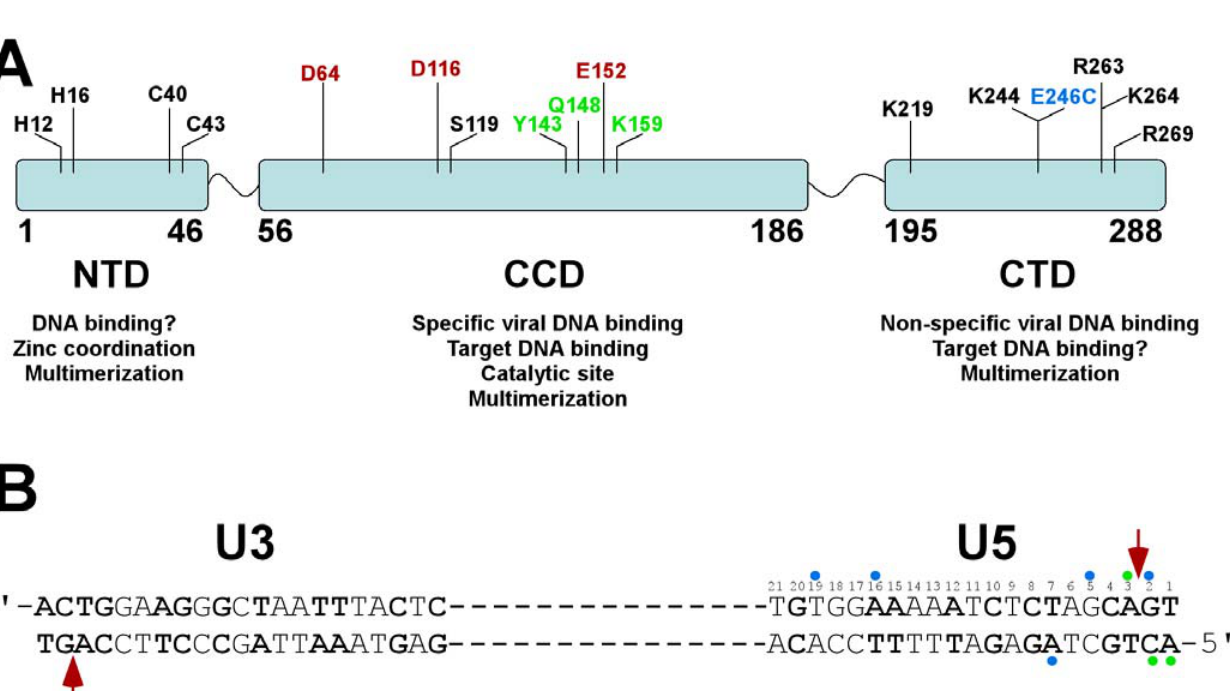
Figure 2. (A) Schematic presentation of the three domain structure of HIV-1 IN. The NTD residues (H12, H14, C40 and C43) coordinate Zn and contribute to the functional multimerization. It is not entirely clear whether the NTD directly binds viral or target DNA. The CCD contains the catalytic DDE motif. This domain interacts with both viral and target DNA. A number of residues (Y143, Q148 and K159) selectively interact with terminal U5 bases, while S119 has been implicated in direct interactions with the target DNA. The CCD is also critical for the functional multimerization. The CTD is highly basic and non-specifically interacts with viral DNA. Several CTD residues implicated in viral DNA binding are indicated. It remains to be determined whether the CTD could also coordinate the target DNA. (B) Sequences of U3 and U5 termini of viral DNA. The base- pairs that are identical in U3 and U5 sequences are in bold. A majority of IN-viral DNA mapping experiments used the U5 sequence and the interacting sites are indicated with circles. Note color coordination between the residues in A and respective nucleotide positions in B. The catalytic residues in A and the arrow pointing to the specific cleavage sites at U3 and U5 termini are in red. The CCD amino acids Y143, Q148 and K159 (colored green) have been shown to selectively crosslink with the terminal nucleotides marked with green circles [60]. The E246C mutant is colored blue and its multiple crosslinking sites [61] in viral DNA are depicted by blue